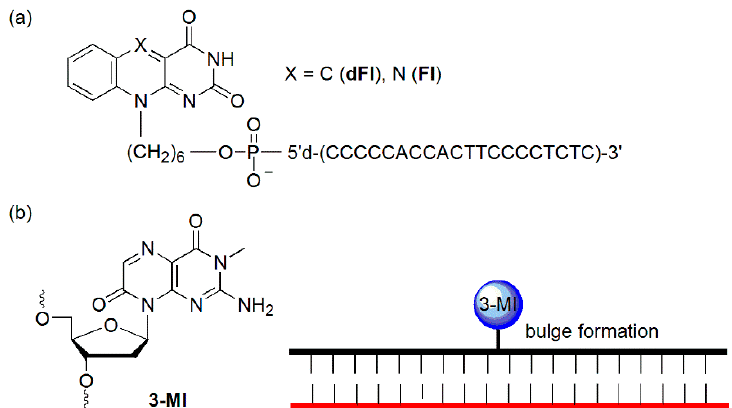
Figure 5. ( a ) Oligonucleotide conjugates of 5-deazaflavin ( dFl ) and flavin ( Fl ) and ( b ) single-base bulge formation of a 3-MI -containing oligonucleotide.